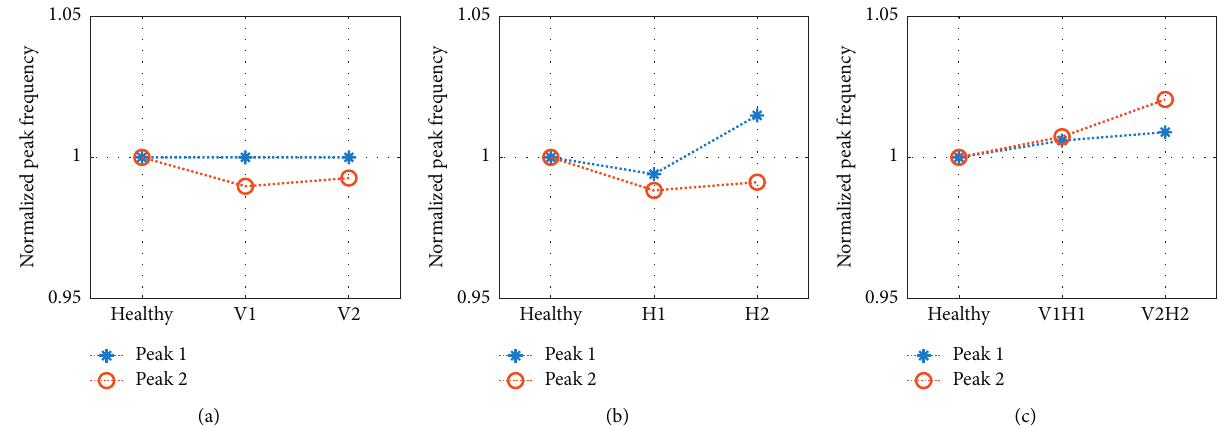
Figure 20: Shifts in peak frequencies caused by PZT debonding defects. (a) Cases: V1, V2. (b) Cases: H1, H2. (c) Cases: V1H1, V2H2.